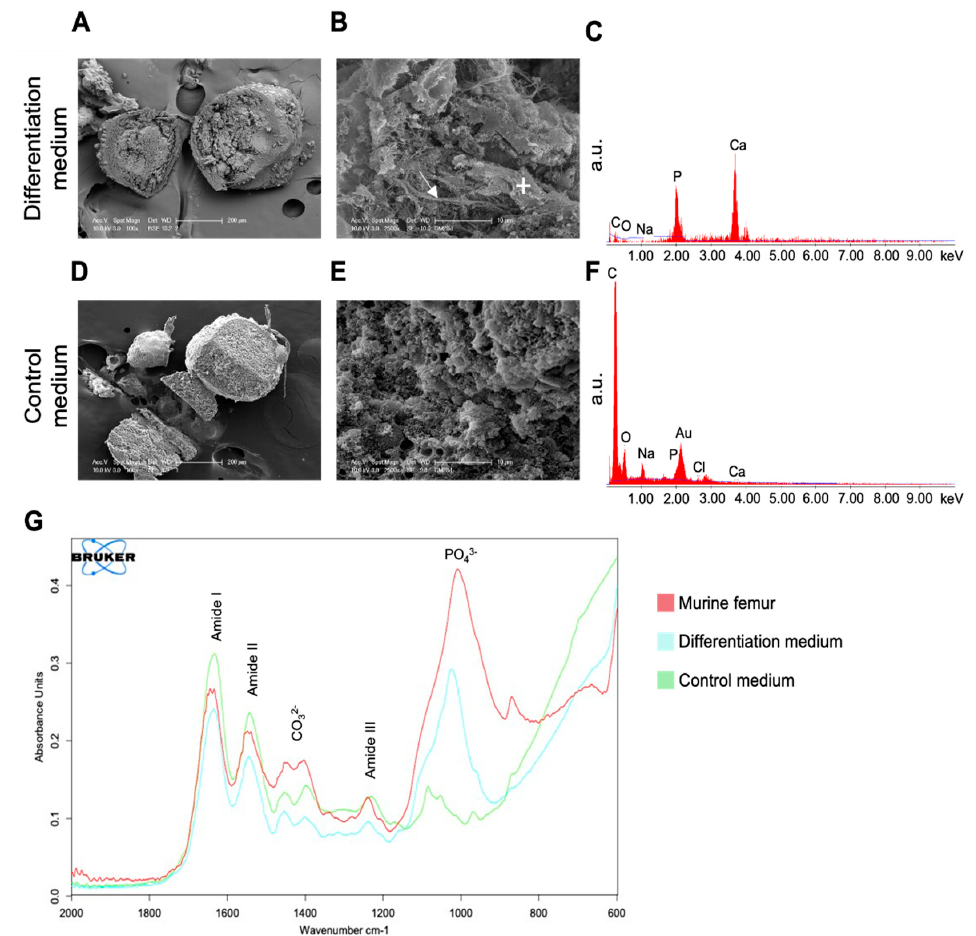
Figure 5. Native bone-like biomineralization in 3D cultures. ( A – C ) Representative SEM/EDX analysis of a spheroid cultured for 28 days in differentiation medium, with cross-section ( A ), magnification ( B ), and EDX spectrum ( C ). ( D – F ) Representative corresponding SEM and EDX analyses of a spheroid cultured under non-mineralizing conditions. ( G ) Representative FTIR absorption spectra of a murine cortical bone specimen (i.e., femur, red), and spheroids cultured for 28 days under either mineralizing (blue) or non-mineralizing culture conditions (green). a.u., arbitrary units; arrow marks a collagen fiber; “+” marks a cell.